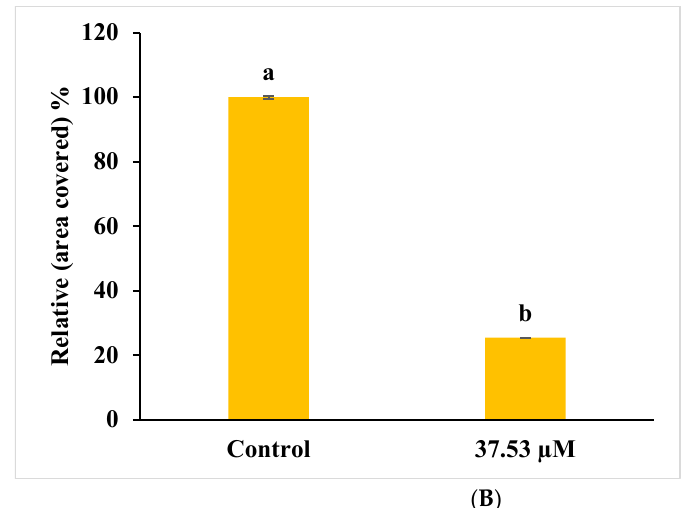
Figure 11. ( A ) Inhibition of the migration of MG-63 cells by BDCe fraction for 24 h.Dotted lines indicated the scratch area. ( B ) Histogram showing quantitative analysis of cell migration using alpha easeFC software. ( a ) Untreated control MG-63 cells ( b ) MG-63 cells treated with BDCe fraction (GI 50 ). Values are expressed as mean ± SE at the level of significance p ≤ 0.05. Data labels with different letters represent significant difference among them.